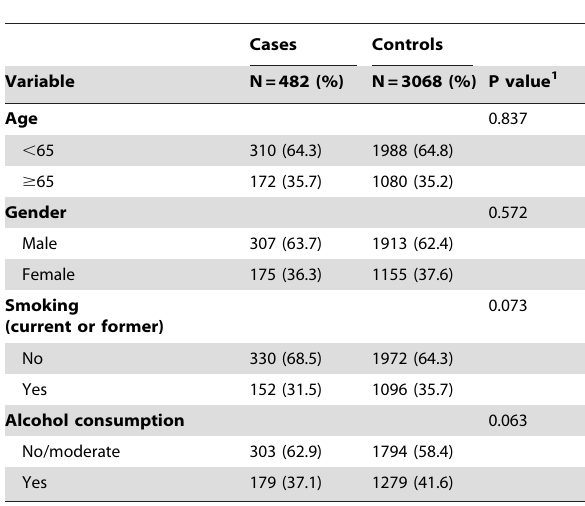
Table 1. Characteristics of malignant melanoma patients and healthy